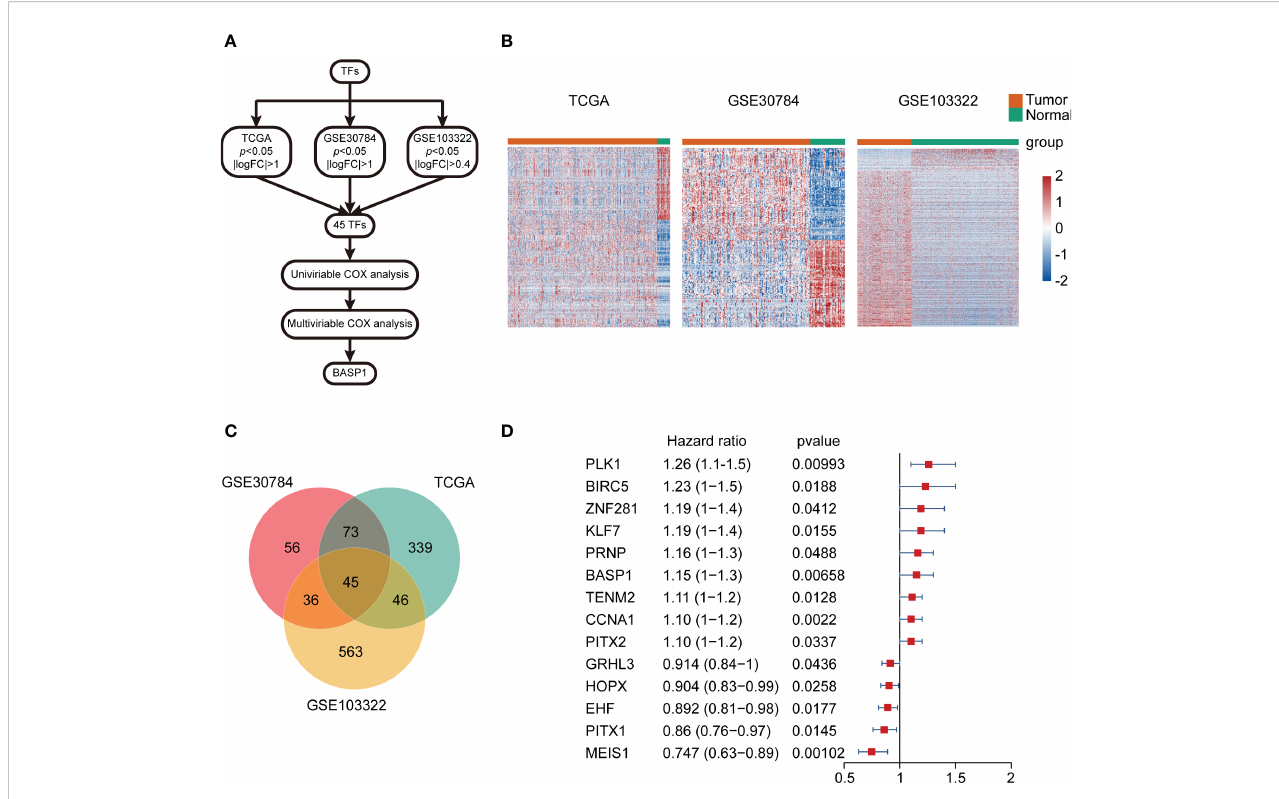
FIGURE 1 The expressions and prognostic values of TFs in HNSCC. (A) Work fl ow of identifying BASP1 in HNSCC. (B) Heatmap of differentially expressed TFs between normal controls and HNSCC tissues in the TCGA database, GSE103322 and GSE30784. (C) Venn plot of the intersection of three cohorts of differentially expressed TFs. (D) The forest plot of 14 TFs correlated with HNSCC overall survival in the univariate Cox regression model.